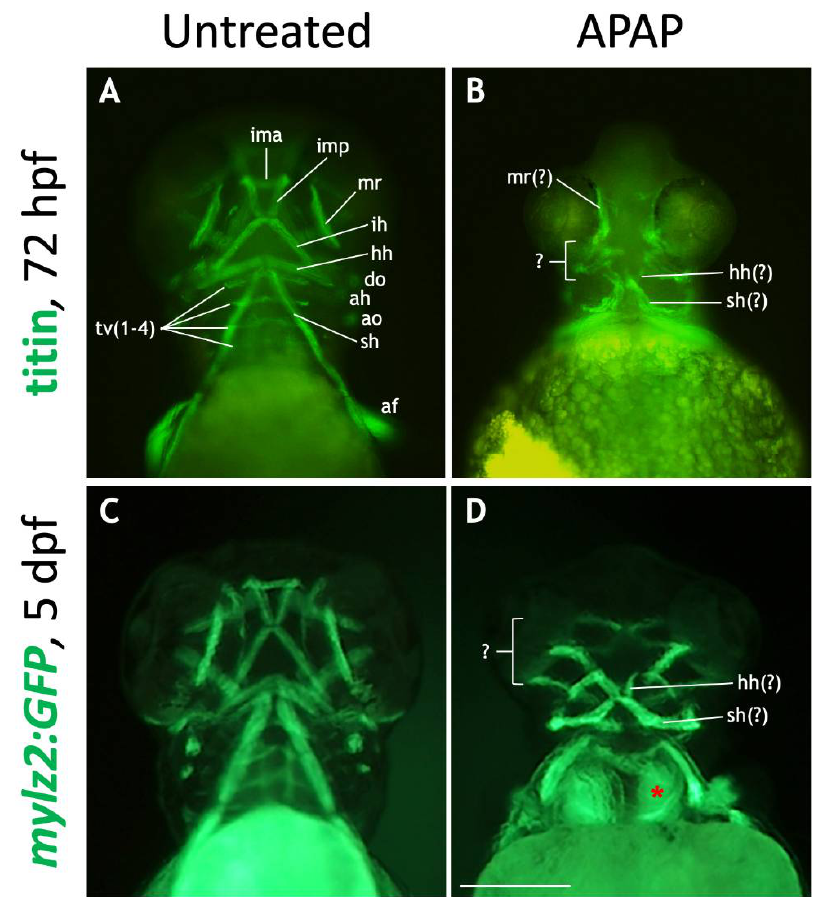
Figure 8. Many craniofacial muscles are absent or disorganized in APAP-treated larvae. ( A , B ): Ventral views of 72-hpf embryos processed for titin immunohistochemistry to label muscles. In an untreated embryo ( A ), ventral muscle types are in focus and labeled according to type. In an APAP-treated embryo ( B ), developing muscles are present but disorganized. ( C , D ): Ventral views of live-imaged, 5-dpf mylz2:GFP larvae which express GFP in skeletal muscles. Compared to an untreated larva ( C ), an APAP-treated larva ( D ) has a reduced number of misarranged craniofacial muscles. Due to missing musculoskeletal elements from branchial arches three though seven, the underlying anterior somites are visible (red asterisk in ( D )). The defects in both titin-stained and mylz2:GFP larvae are variable, but the most common arrangements are shown here. Abbreviations (after Schilling and Kimmel 1997): aboral fin, af; adductor hyoideus, ah; adductor opercula, ao; dilator opercula, do; hyohyoideus, hh; interhyoideus, ih; intermandibularis anterior, ima; intermandibularis posterior, imp; medial rectus, mr; sternohyoideus, sh; transversus ventralis, tv. Scale bar (in ( D )) for ( A – D ), 200 µ